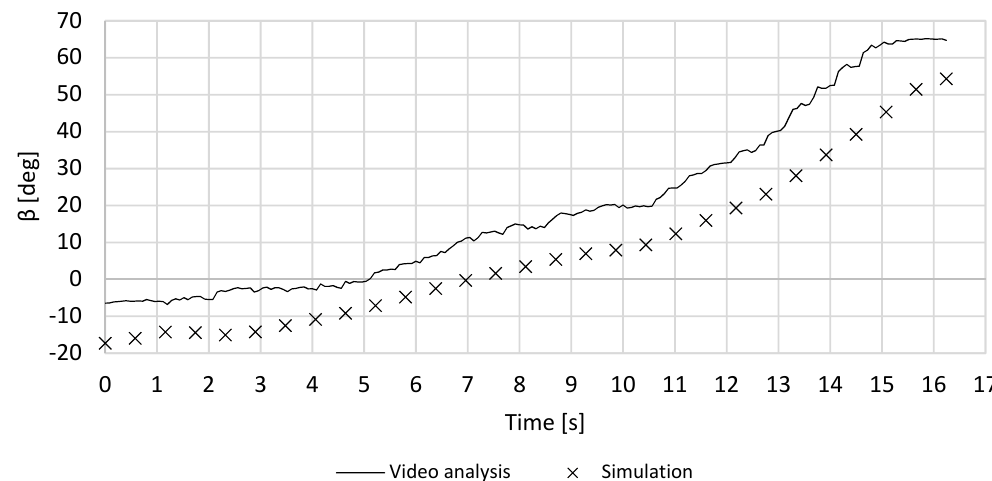
Figure 22. Deviation error of δ versus time.